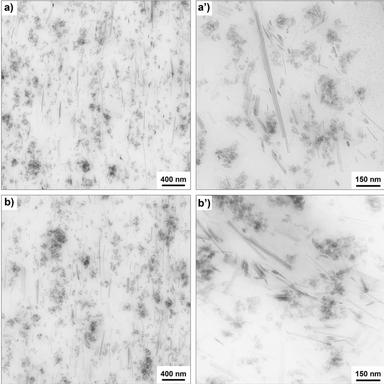
TEM images at different magnifications of (a, a') Sep+SiO2/NR and (b, b') MB-Sep+SiO2/NR samples.